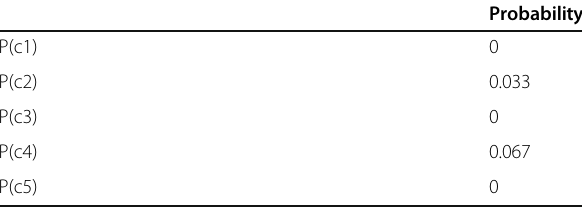
Table 3 The calculation of first predicted point probability